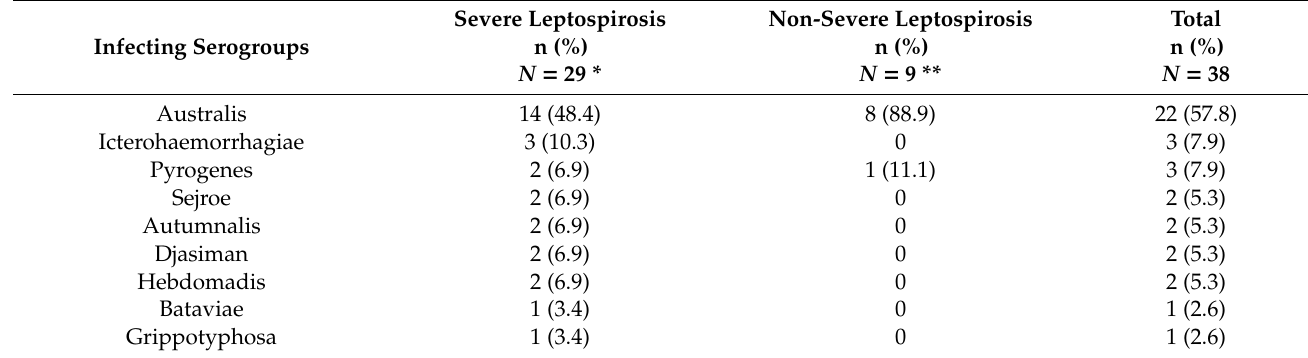
Table 2. Serogroups (with the highest titer by a microscopic agglutination test (MAT)) of confirmed leptospirosis from 12 hospital-based sites in Thailand, 2017. Infecting Serogroups